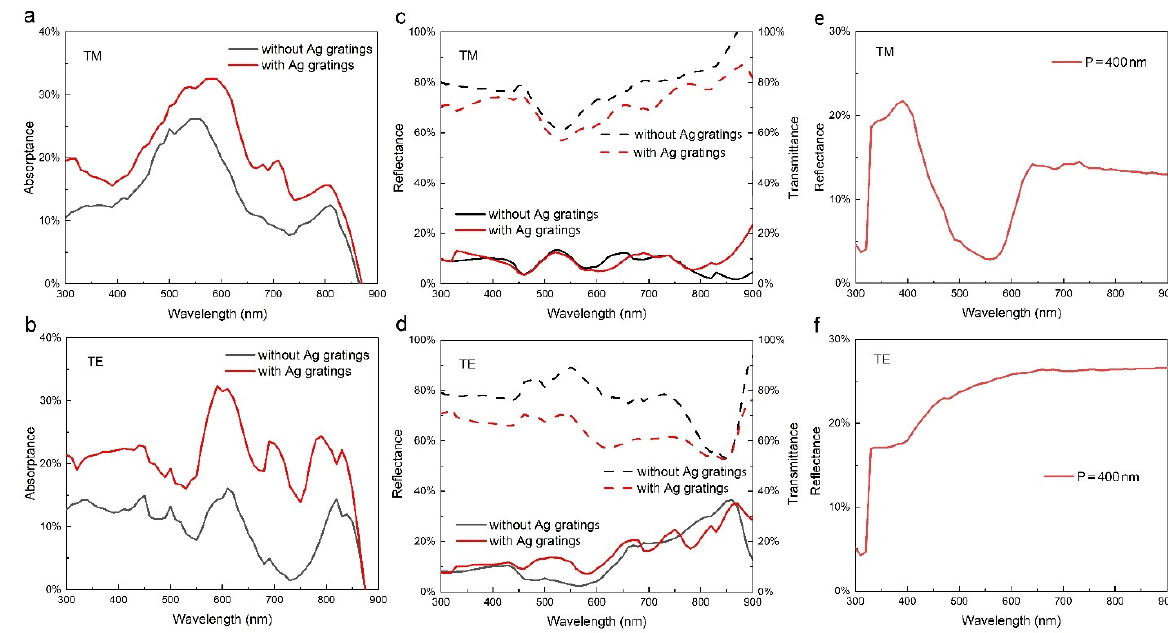
Figure 2. ( a , b ) The absorptance of the laterally oriented NW without (black) and with (red) Ag gratings for TM and TE polarized light, respectively; ( c , d ) The reflectance (solid line) and transmittance (dotted line) of the laterally oriented NW without (black) and with (red) Ag gratings for TM and TE polarized light, respectively; ( e , f ) The reflectance of diffracted light from Ag gratings for TM and TE polarized light, respectively. The grating period and widths are 400 nm and 200 nm, respectively, and the diameter of NW is 180 nm.